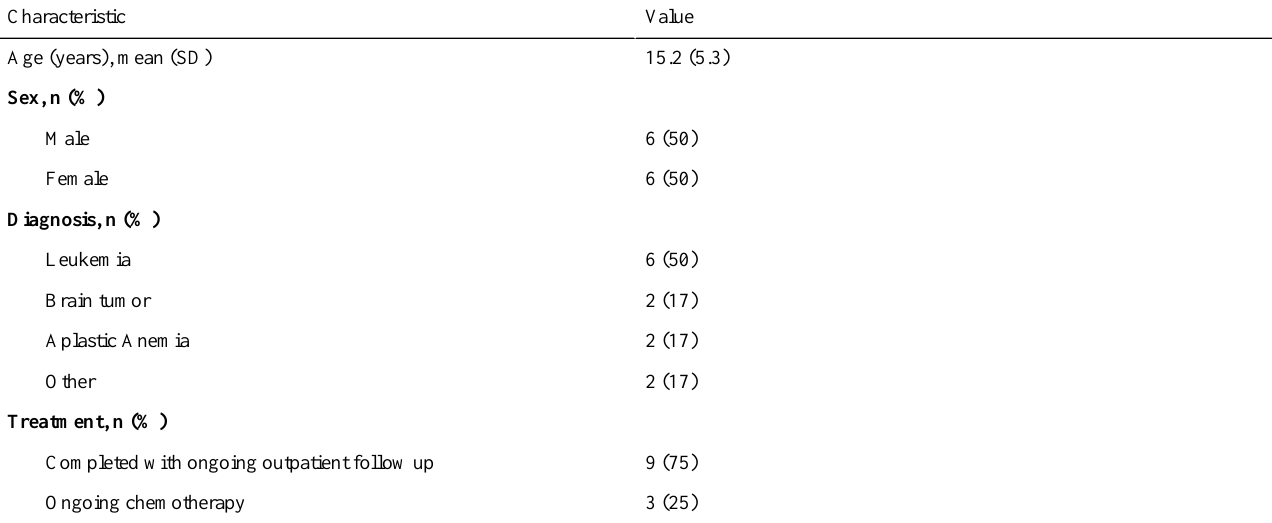
Table 1. Characteristics of focus group discussion participants